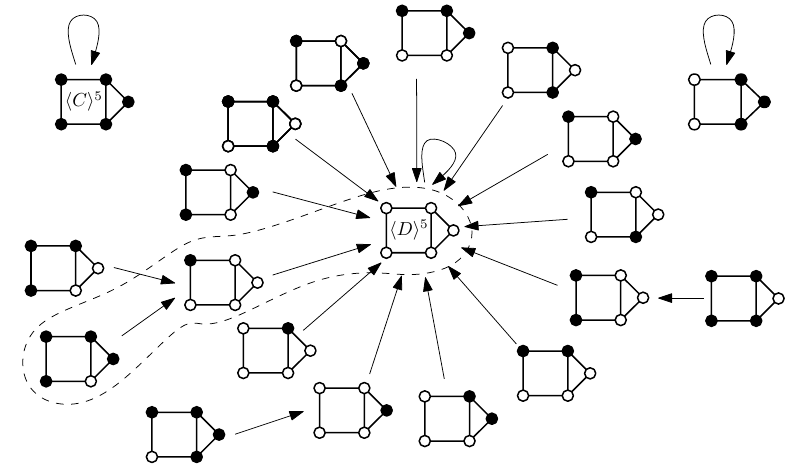
The state graph for the ESPD on the underlying graph in Figure 1(a), with a = 4 and b = 1 3